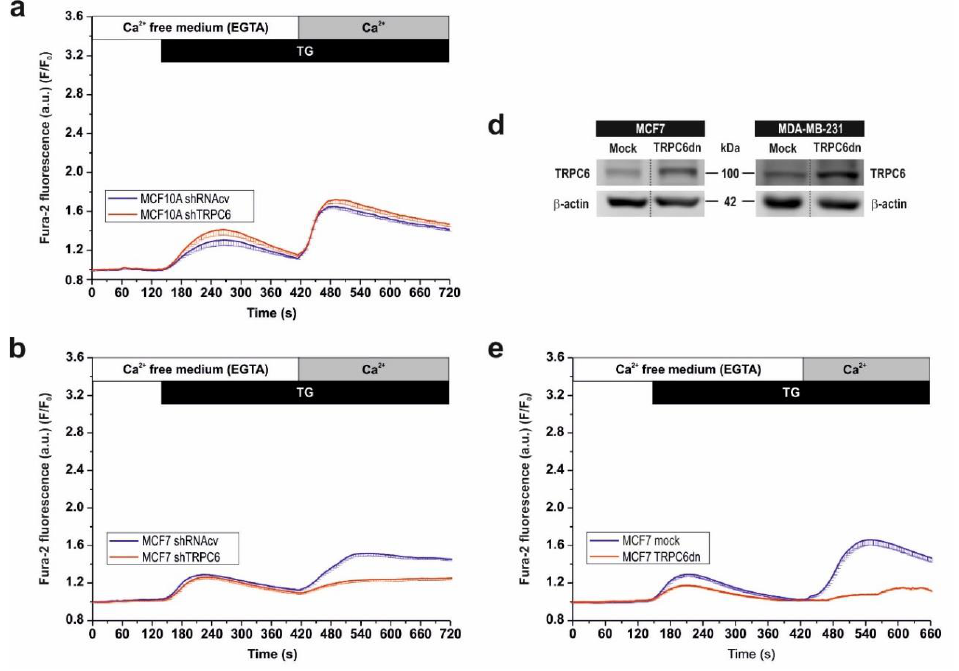
Figure 5. Cont. Figure 5.